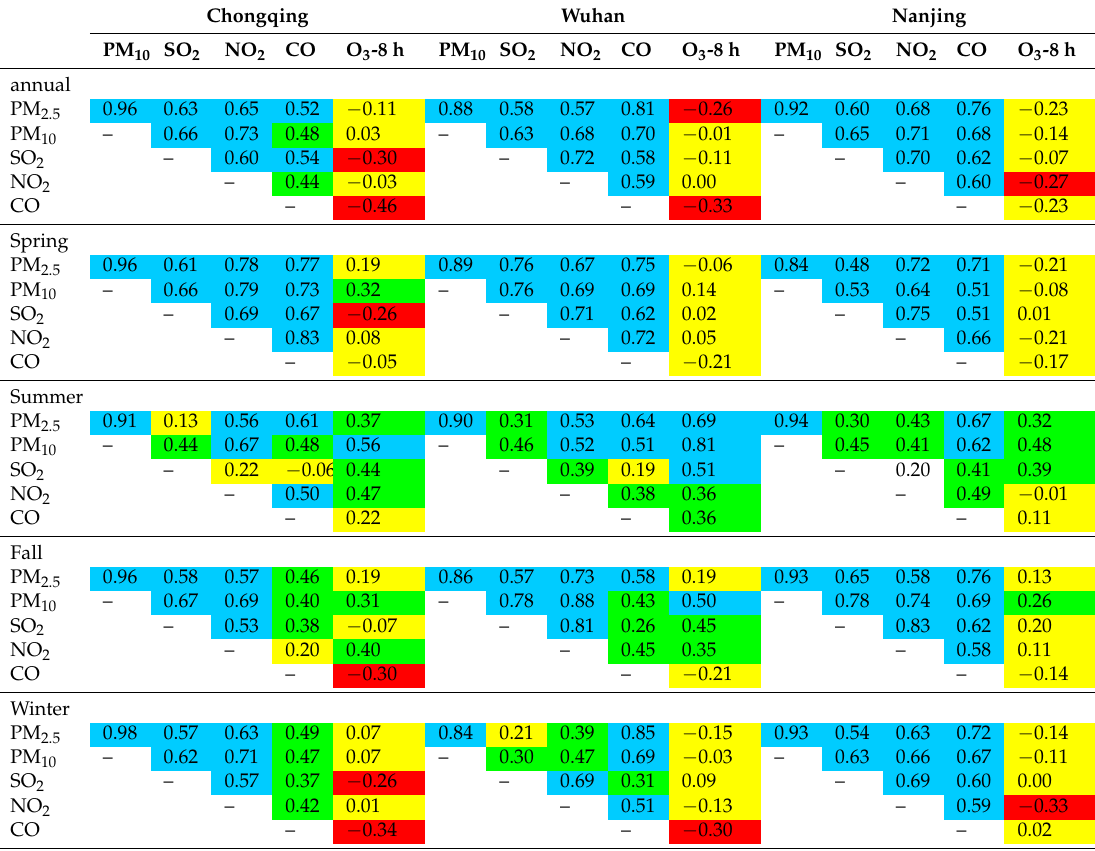
Table 6. Pearson correlation coefficients of air pollutants in the three cities based on annual and seasonal data in 2015–2016. Different colors represent different ranges: light blue (R ≥ 0.5, strong positive correlation), green (0.5 > R ≥ 0.25, moderate positive correlation), yellow (0.25 > R ≥ − 0.25, weak correlation), red ( − 0.25 ≥ R ≥ − 0.5, moderate negative correlation). Chongqing Wuhan Nanjing O 3 -8